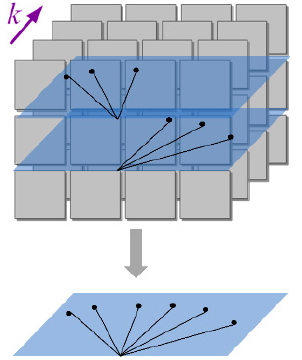
Figure 2. 3D to 2D parallel orthographic projection.